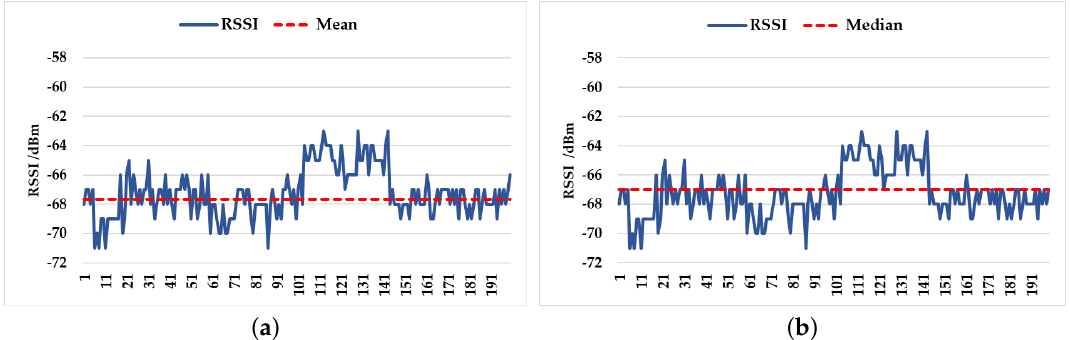
Figure 3. ( a ) The relationship between the RSSI set and its mean, and ( b ) the relationship between the RSSI set and its median.